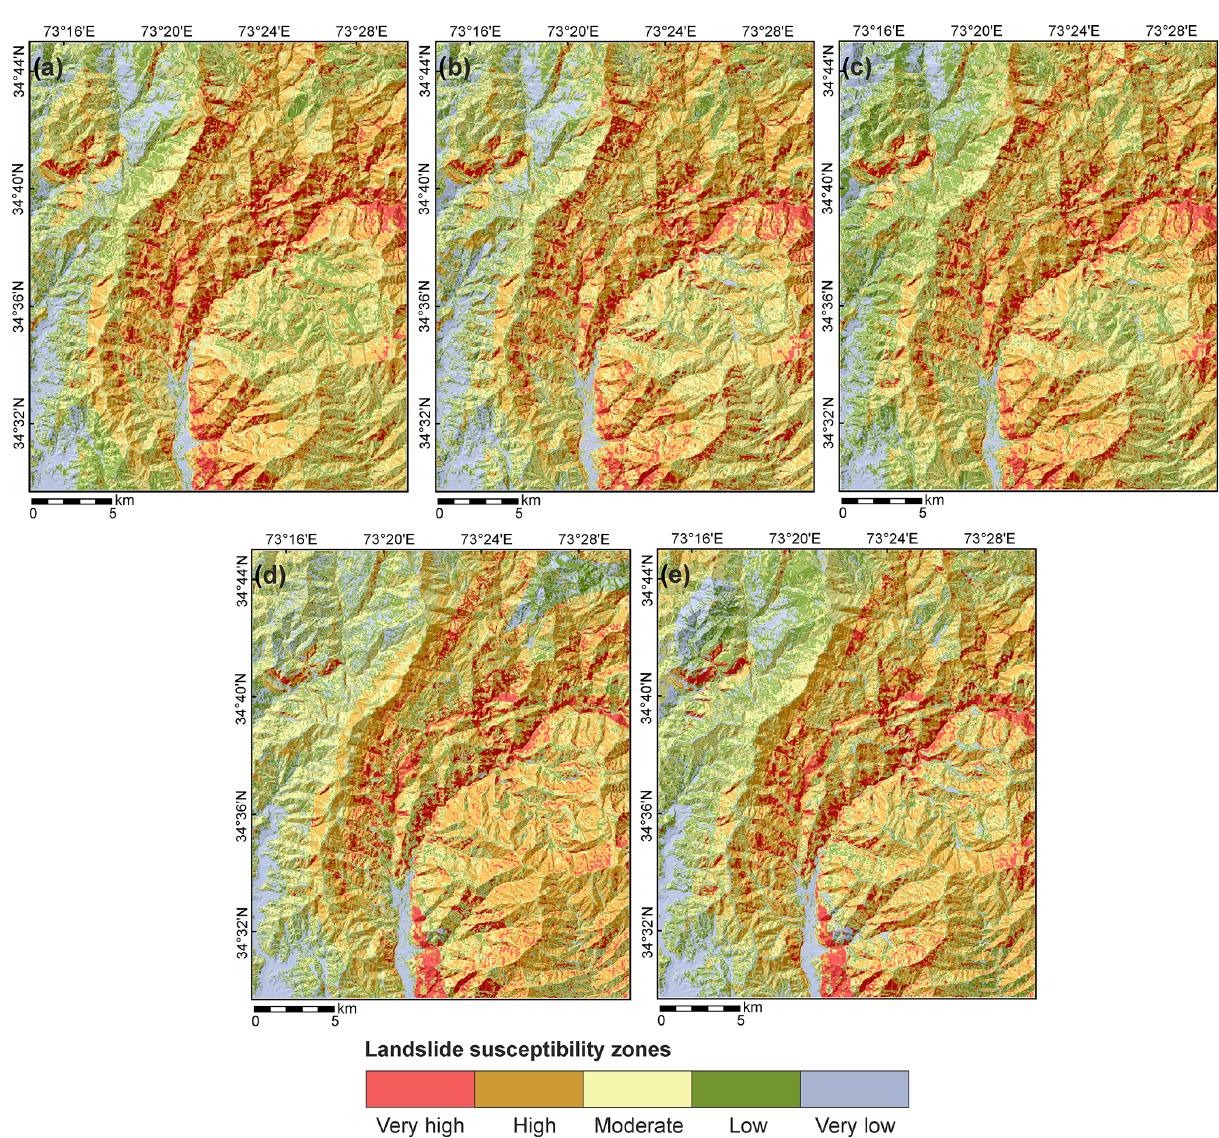
Figure 12. Landslide susceptibility zones based on different models. (a) WoE. (b) LR_d. (c) LR_c. (d) ANN_d. (e) ANN_c. Very high contains about 50%, high about 30%, moderate about 15%, low about 4%, and very low about 1% of all landslide